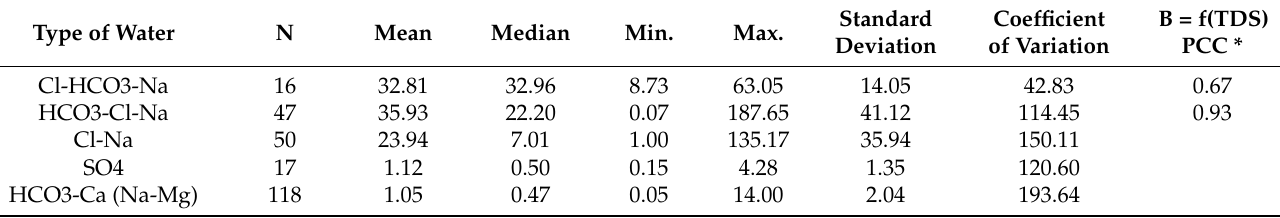
Table 3. Descriptive statistics of the curative water